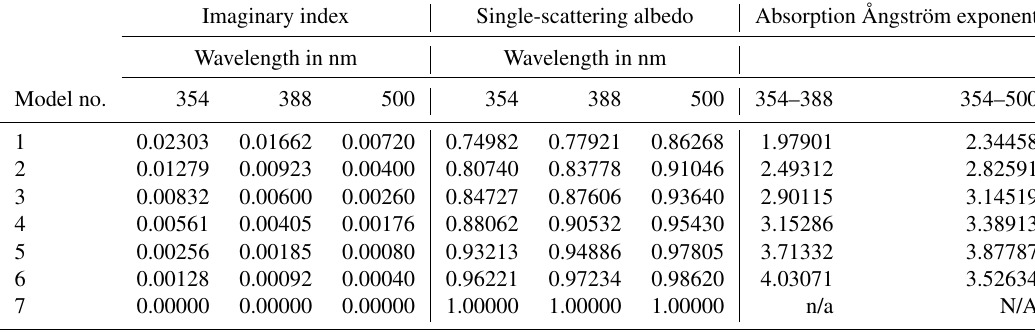
n/a: Not applicable. Real refractive index = 1.55.